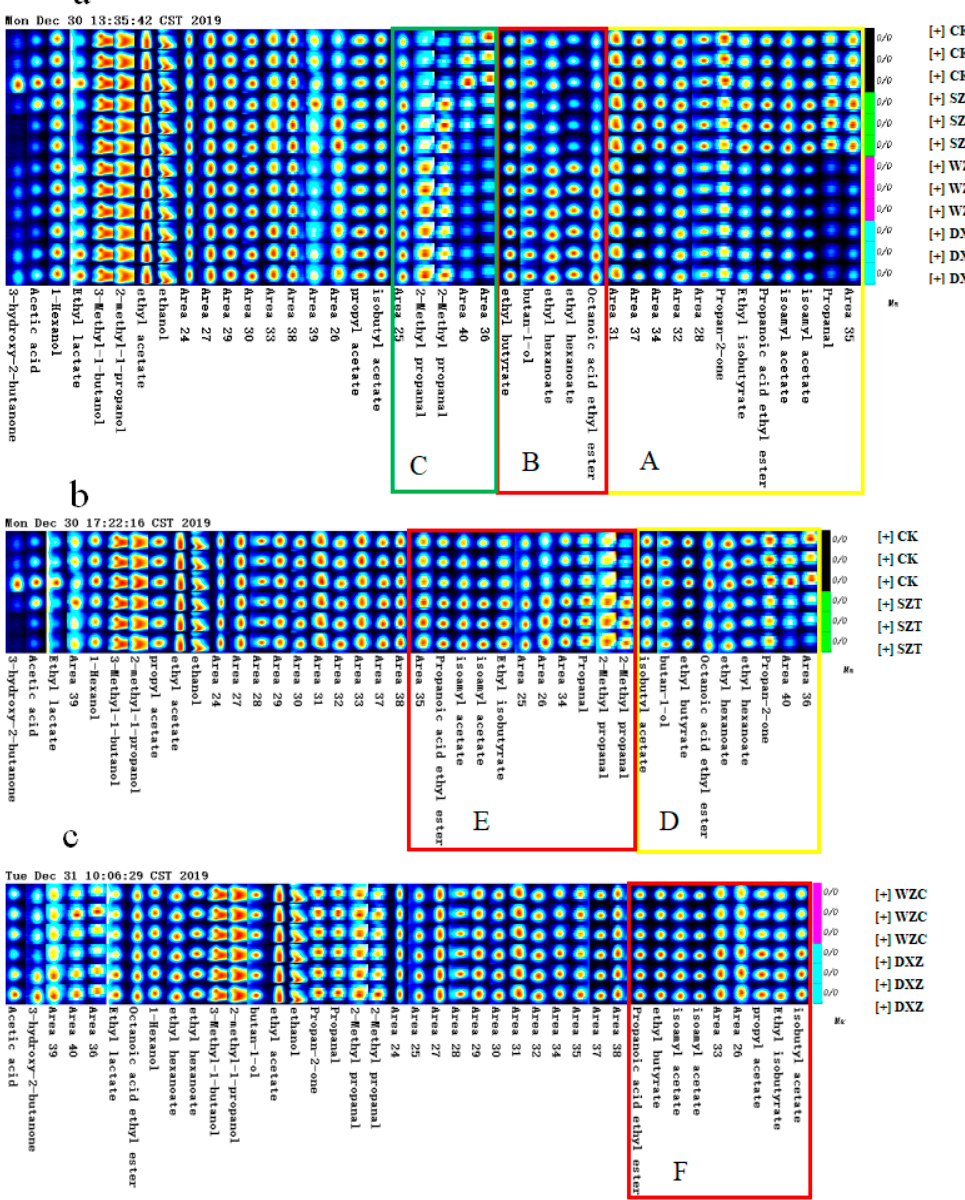
Figure 3. Analyzed by GC-IMS. ( a ) Comparison of gallery plot in all wine samples (CK, SZT, WZC, and DXZ wine samples). ( b ) Comparison of gallery plot between the control (CK) and triadimefon-treated (SZT) wine groups. ( c ) Comparison of gallery plot between the tebuconazole-treated (WZC) and paclobutrazol-treated (DXZ) wine groups. A, B, C, D, E, F represent regions where volatile compounds differ significantly.